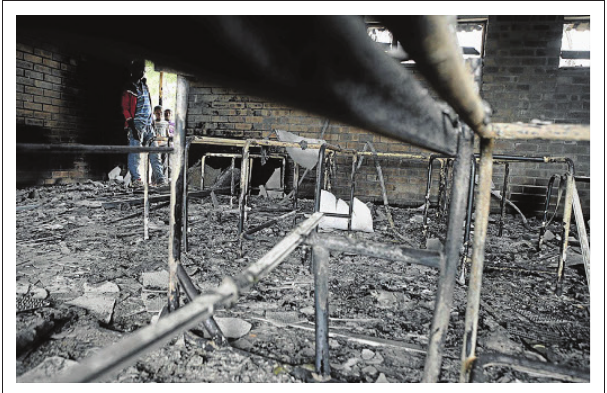
FIGUUR 1: Frank Mukhaswakule Primary was een van die dertien skole wat deur betogers in Vuwani, Limpopo aan die brand gesteek